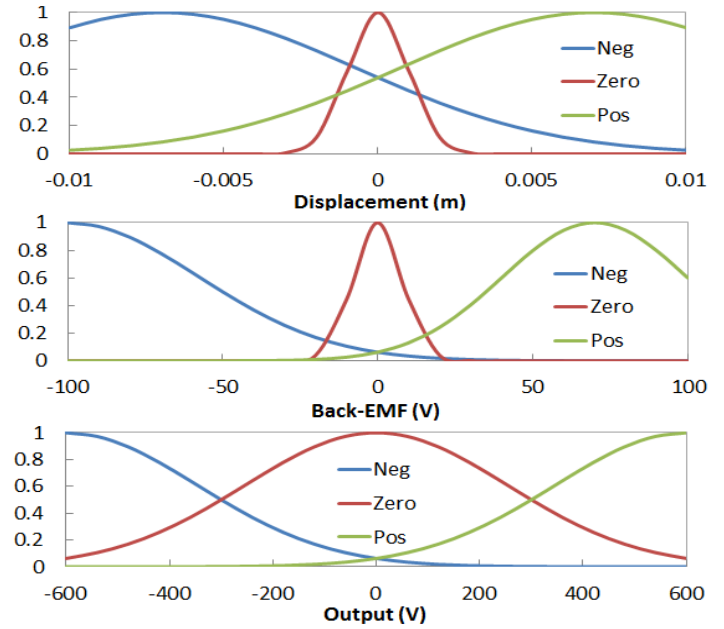
Figure A1. Fuzzy membership functions for the in-phase voltage